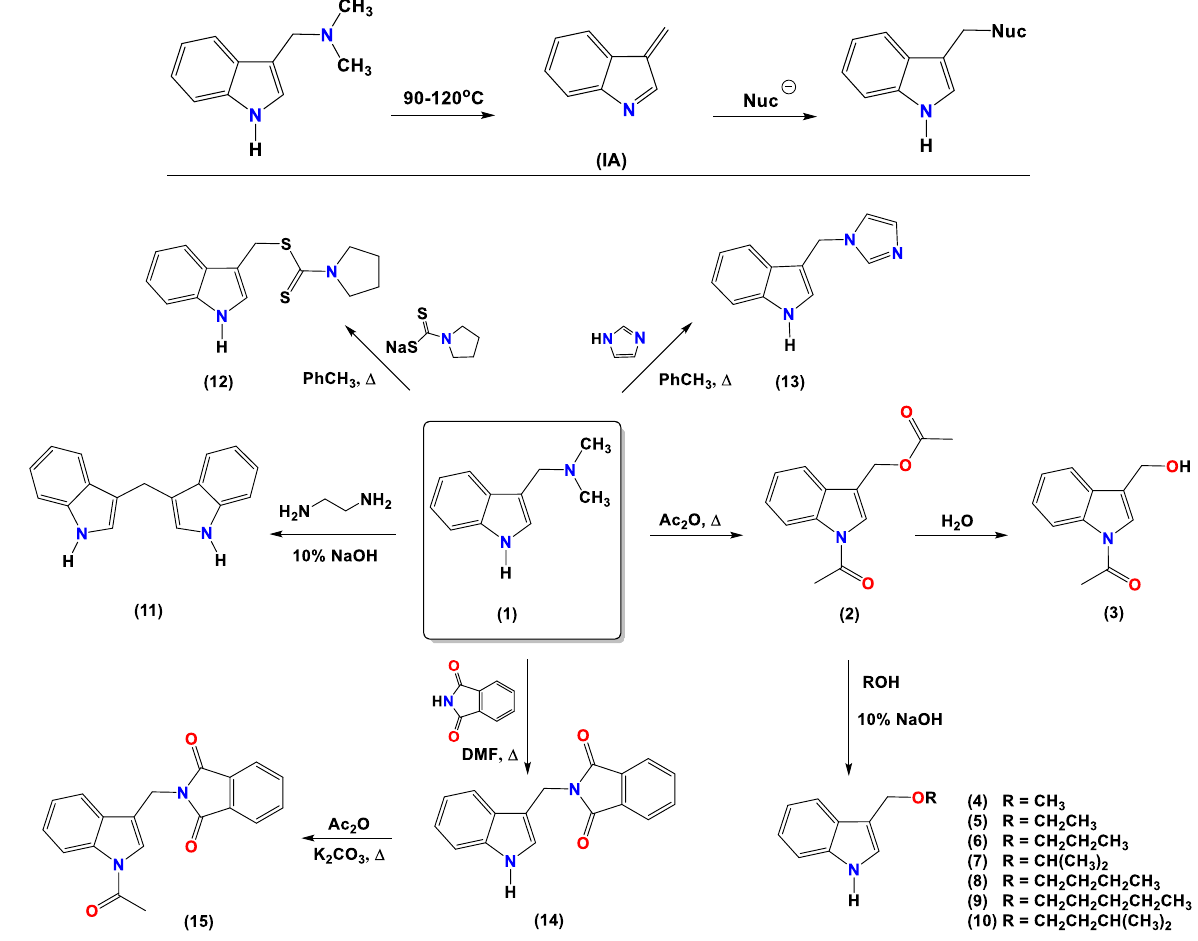
Figure 1. Synthesis of indole derivatives 2–15. (ChemDraw Professional